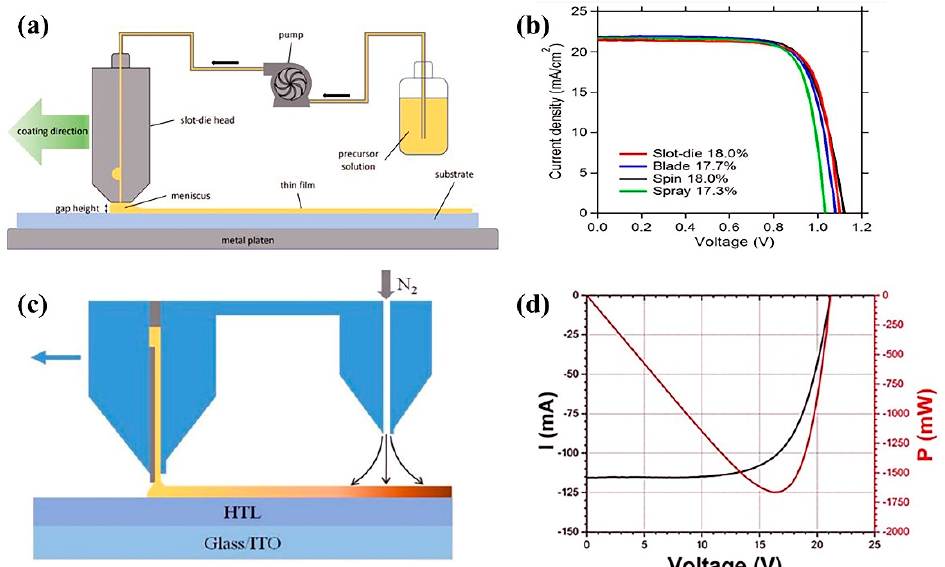
Figure 7. ( a ) Schematic diagram of the critical steps involved in the slot-die coating of perovskite thin films, ( b ) J–V curves of PSCs layer deposited by slot-die coating, blade coating, spin coating, and spray coating [90]. Copyright 2018 Royal Society of Chemistry. ( c ) The slot-die coating process for preparing MAPbI 3 films [92]. Copyright 2018 Elsevier. ( d ) 15.24 cm 2 perovskite module and current–voltage ( I–V) curve, respectively [93]. Copyright 2018 Elsevier.